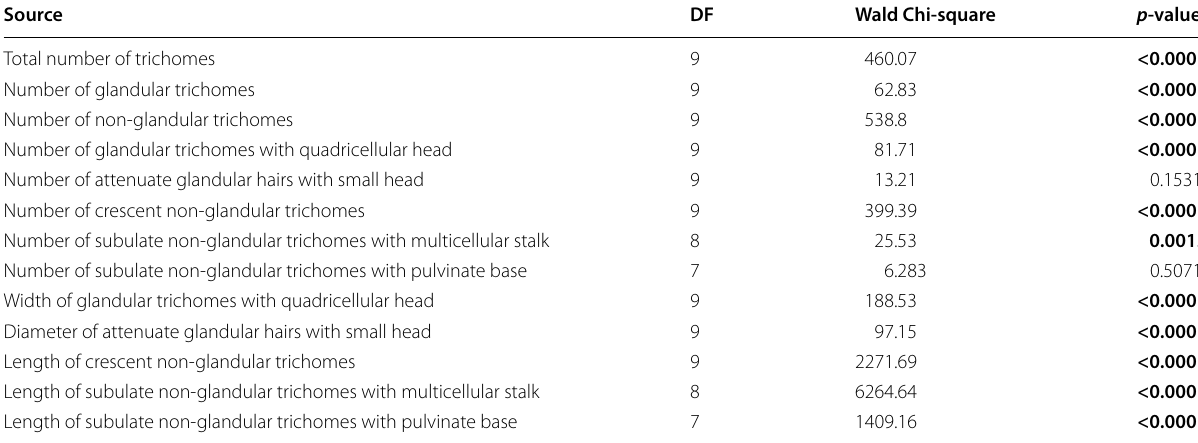
Table 2 Results of Generalized linear regression with Poisson distribution of the number and dimensions of